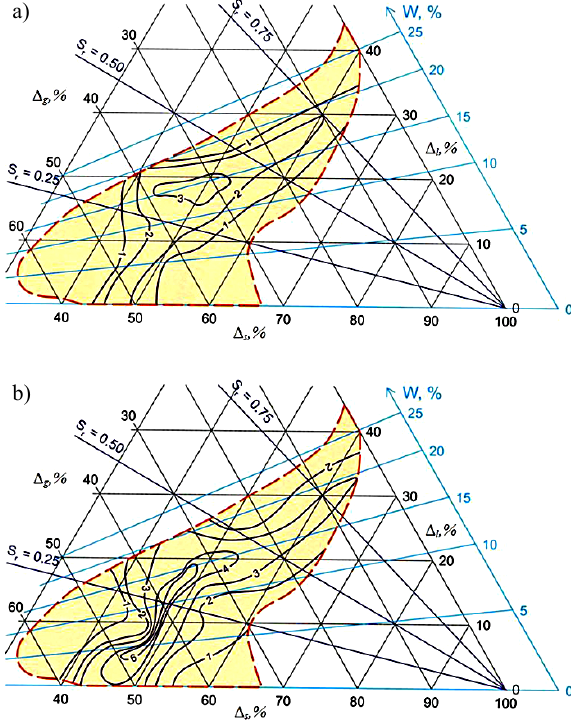
Fig. 8. Diagram of humidity gradient values ( Δ W) ch (%/cm): a – through 4 h; b – through 20 h after the experience beginning depending on sand phase